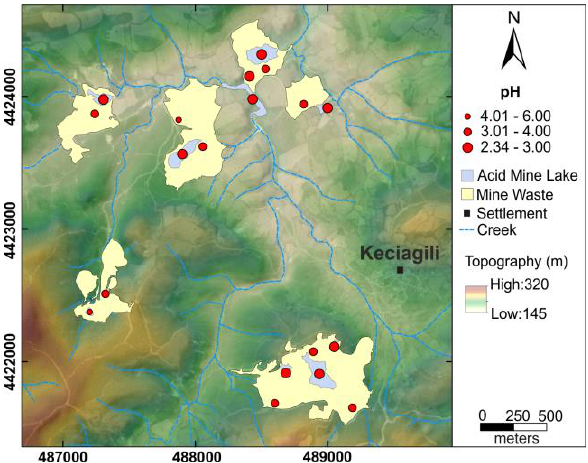
Figure 3. pH distribution of mine wastes and acid mine lakes